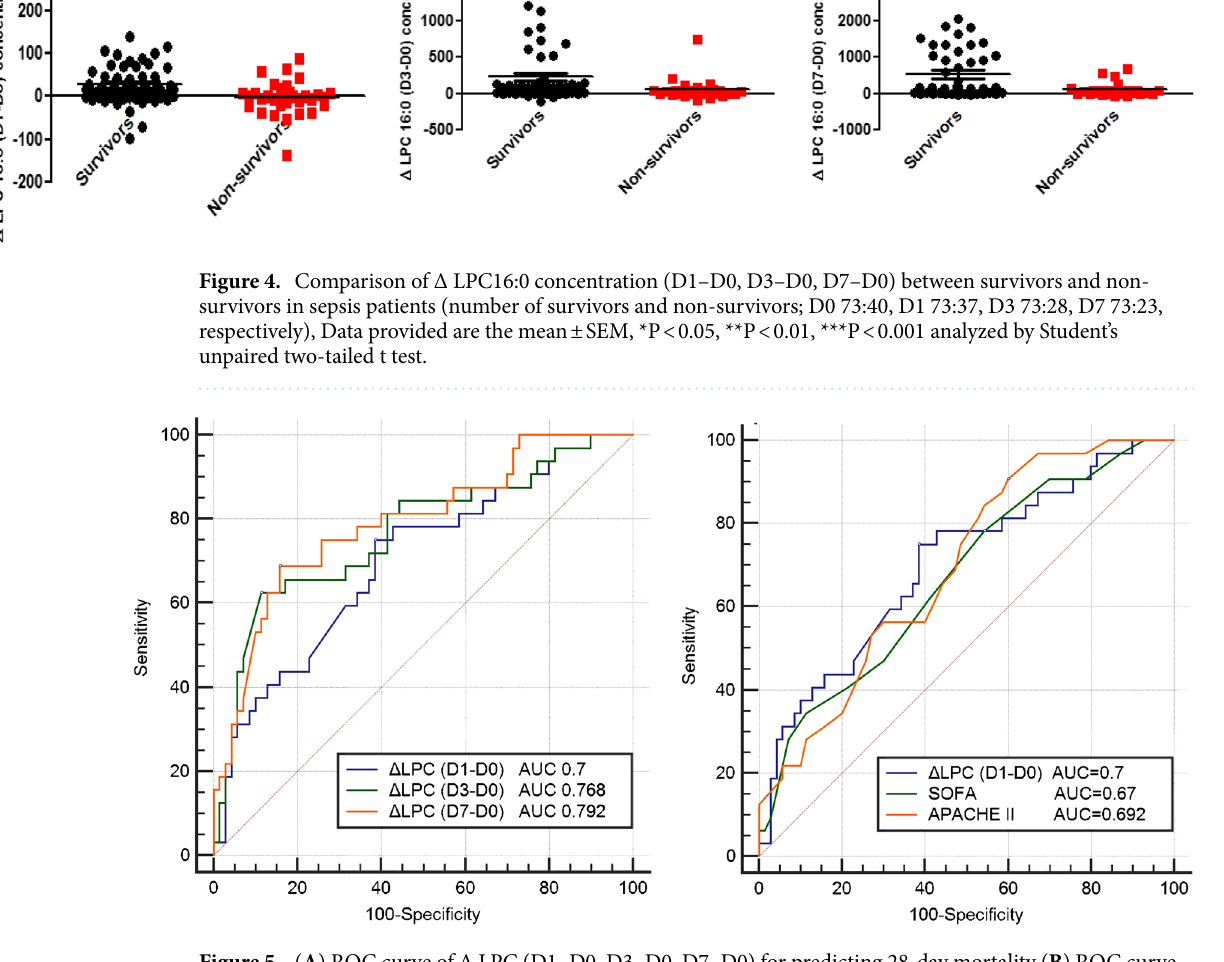
Figure 5. ( A ) ROC curve of Δ LPC (D1–D0, D3–D0, D7–D0) for predicting 28-day mortality ( B ) ROC curve of Δ LPC (D1–D0) compared to SOFA, APACHE II score. In ROC curve comparisons, the AUC of ΔLPC